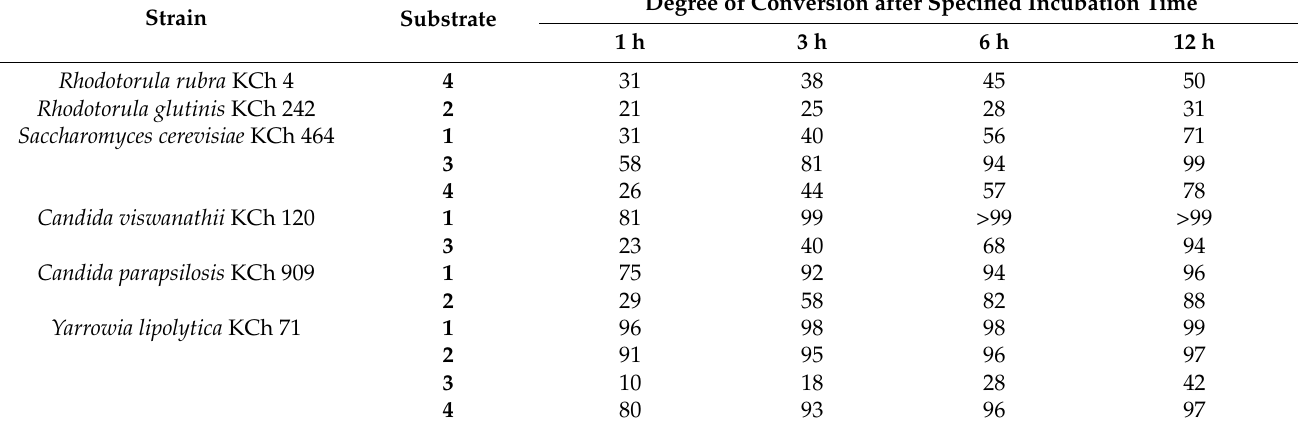
Table 2. Percentage of biotransformation products of 2 (cid:48) -hydroxybromochalcones in the 1st, 3rd, 6th and 12th hours of the reaction.